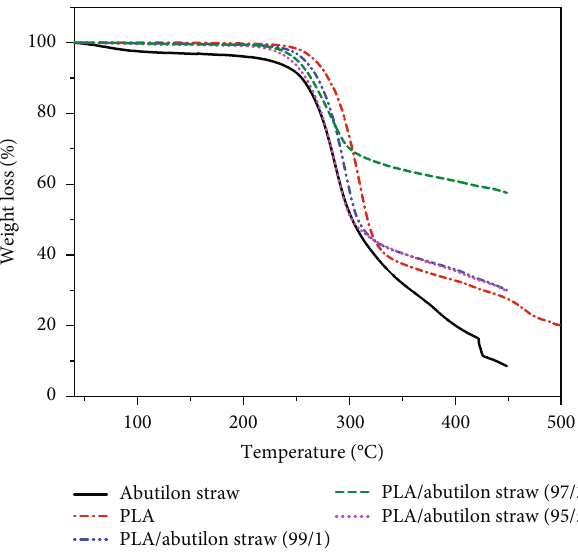
Figure 3: TGA curves of PLA and PLA/abutilon straw